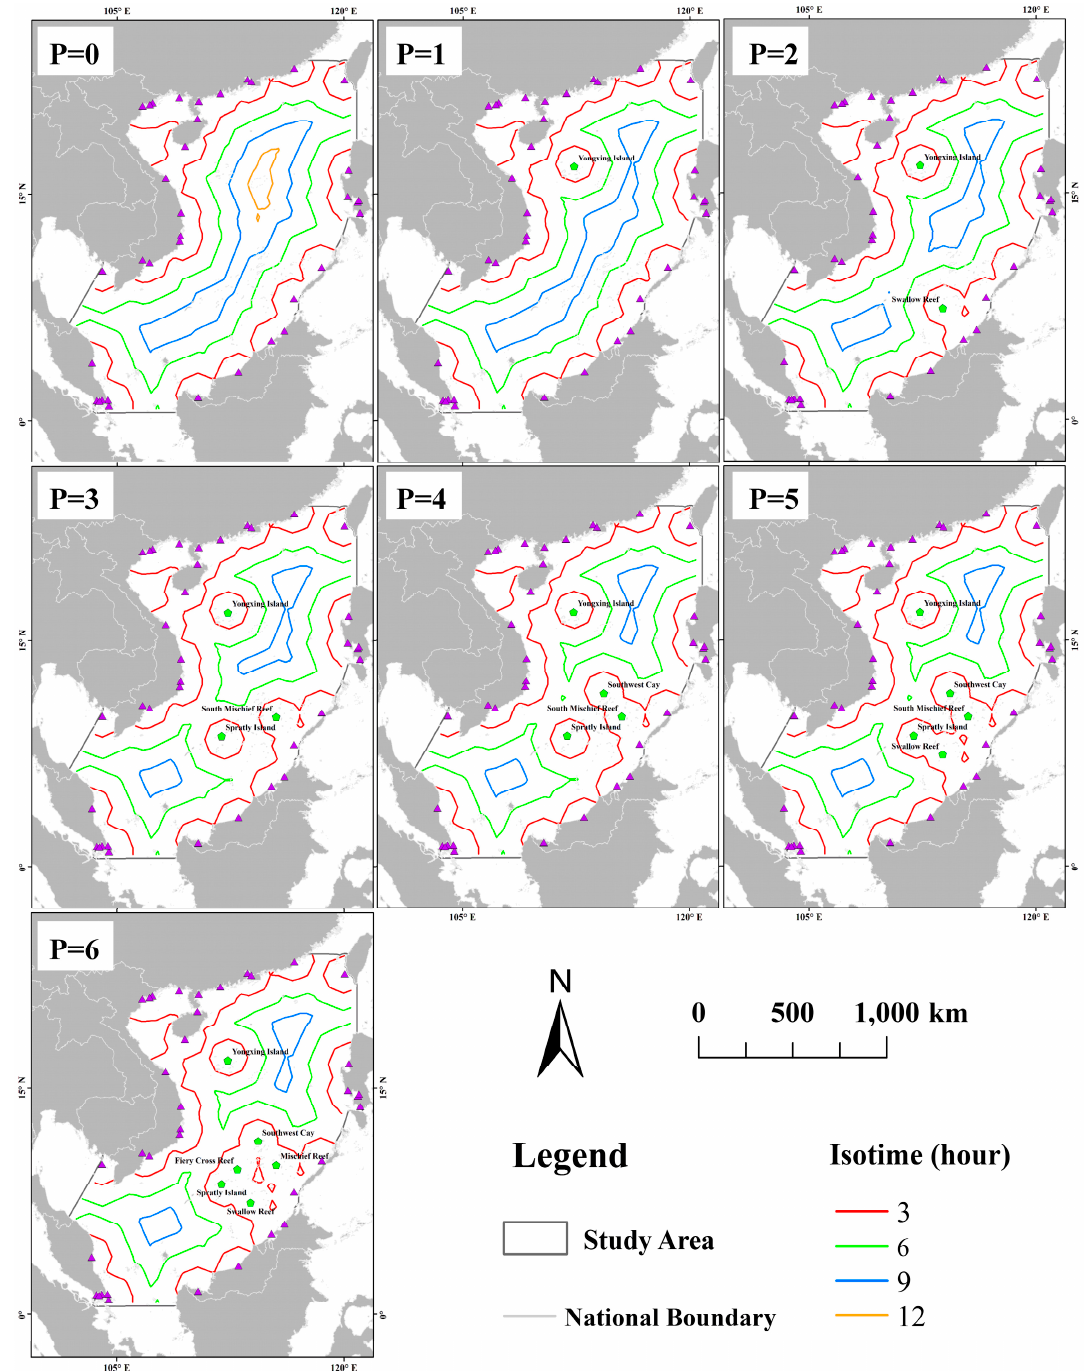
Figure 8. Response times with the maximum coverage solution arrangements. The purple triangles represent the inshore SAR bases, and the green pentagons represent potential island bases.